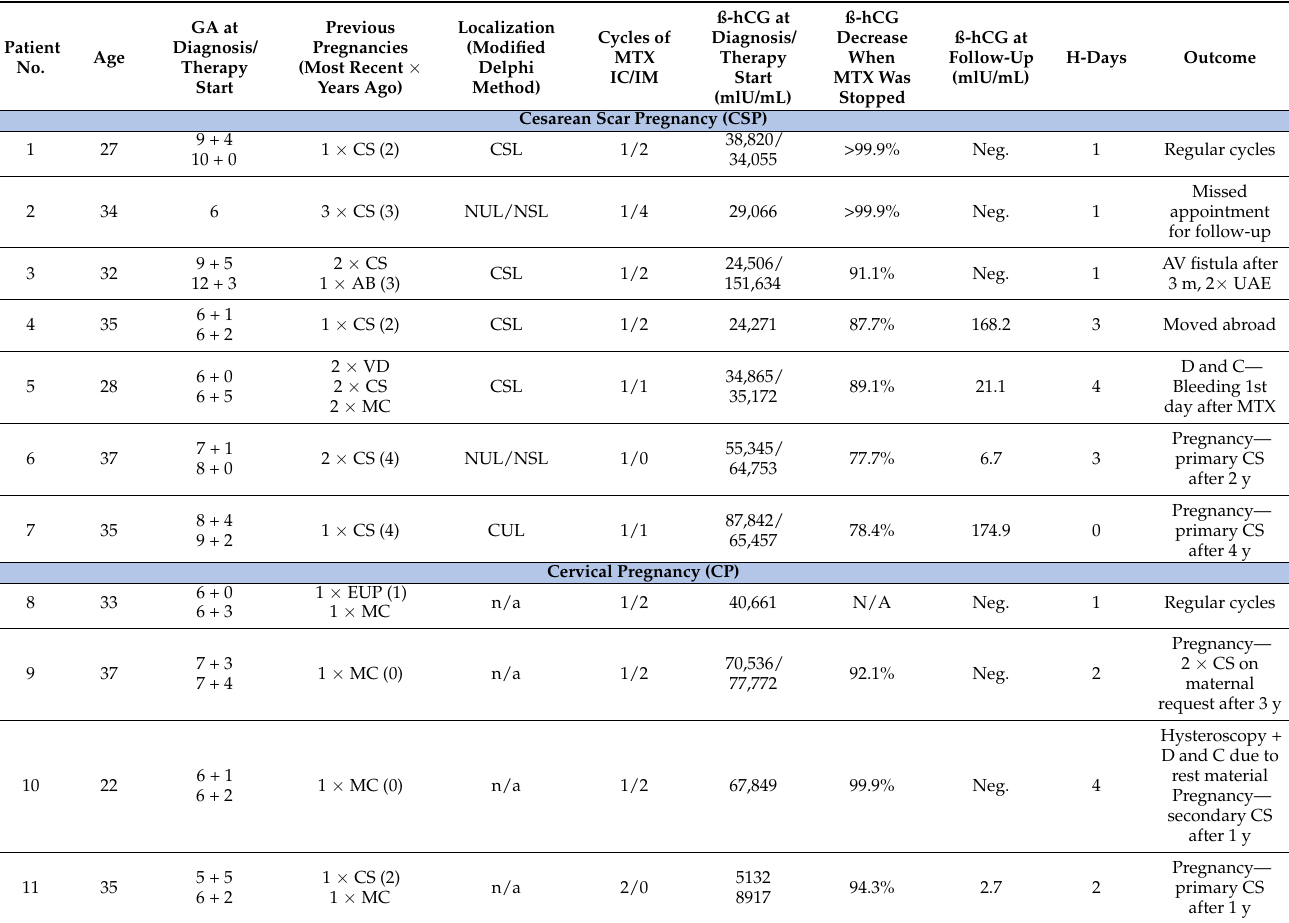
Table 1. All patients with ectopic pregnancies received IC MTX at the Department of